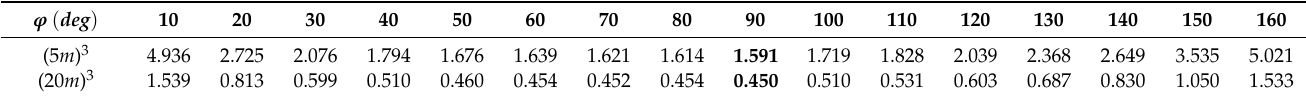
Table 6. The 3D RMSPE ∆ p (m) with varying ϕ in the 5 m × 5 m × 5 m and 20 m × 20 m × 20 m environments for the NLOS condition.